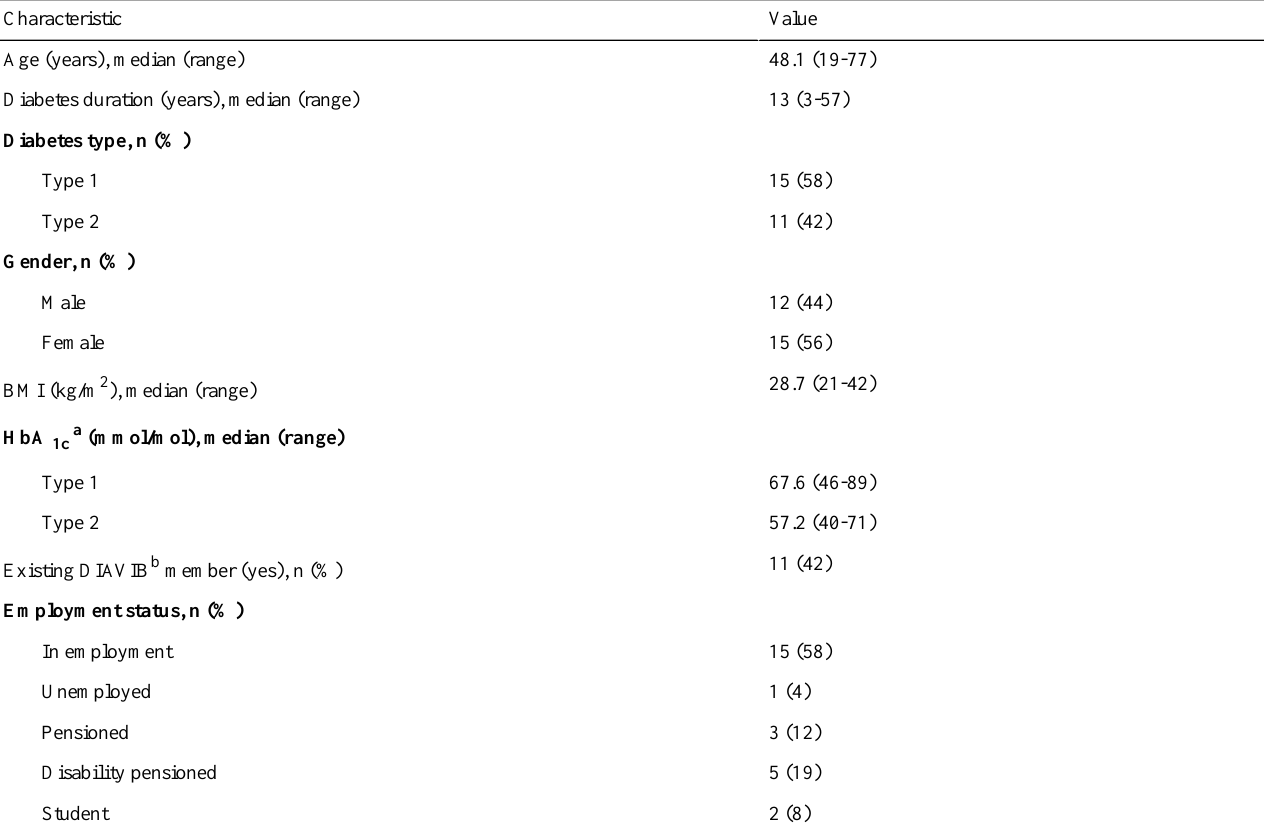
Table 1. Study participant characteristics (N=26).